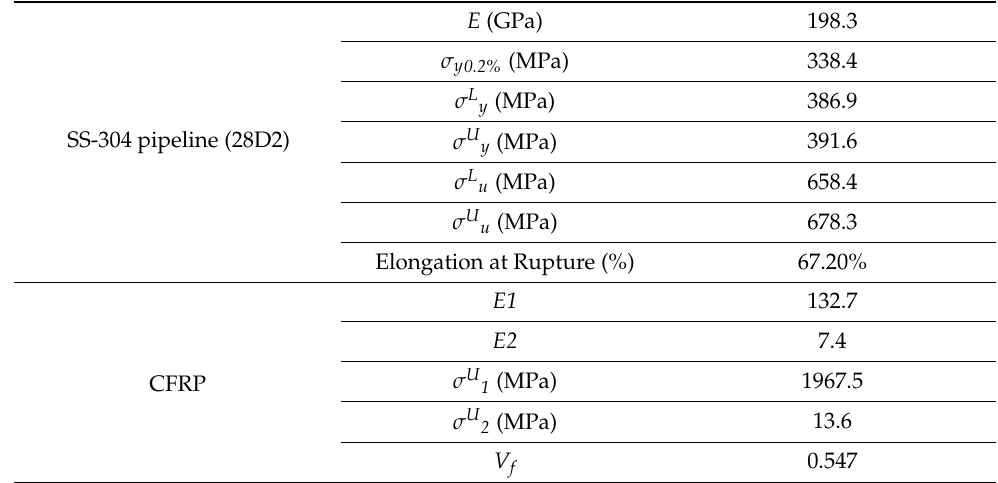
Table 2. Steel pipe and CFRP material parameters [44].